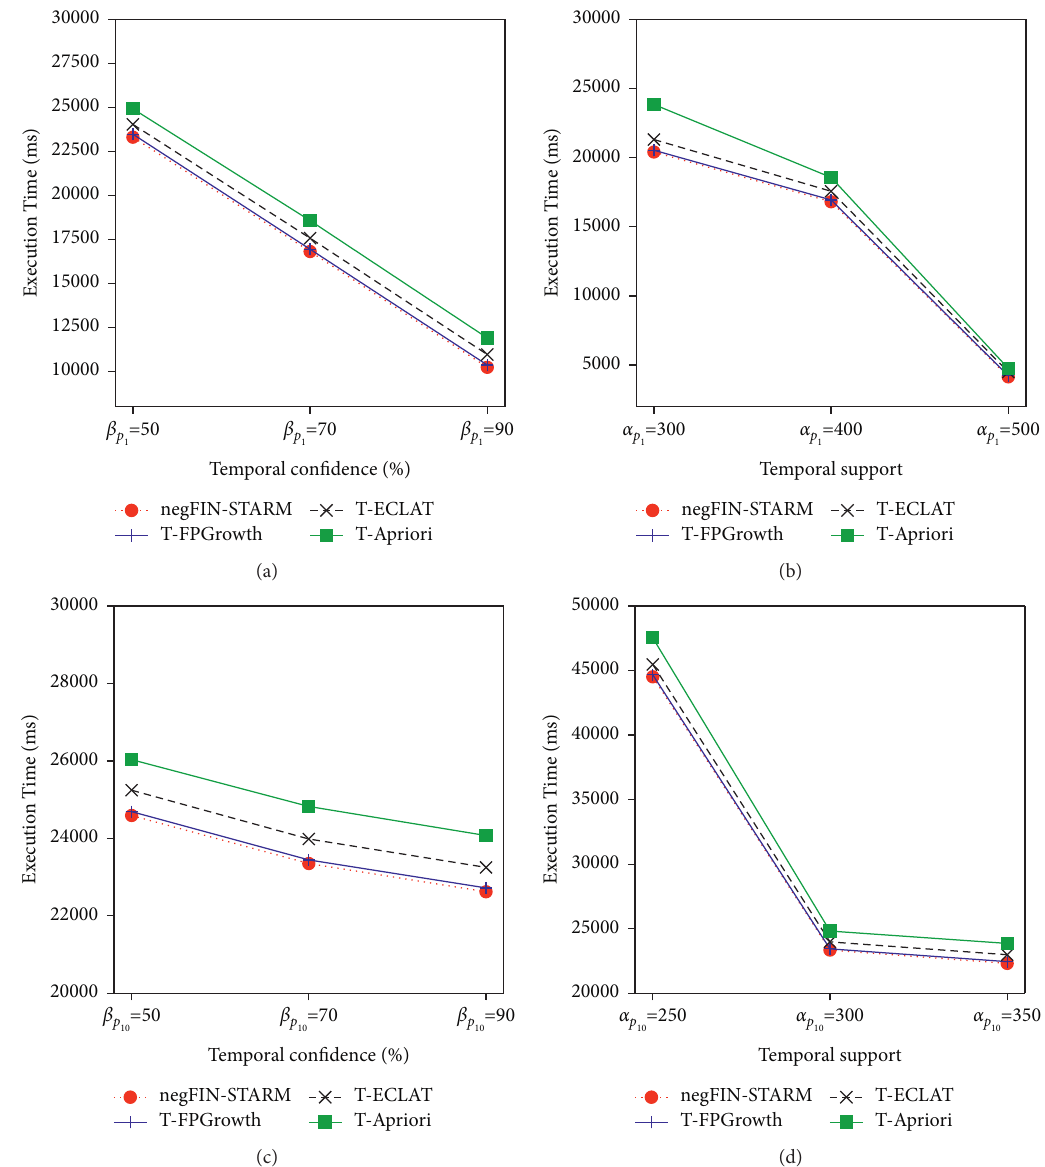
Figure 4: The runtime comparison of four methods based on the mushroom data set. (a) Q � p � 70%. (c) Q � p β p 1